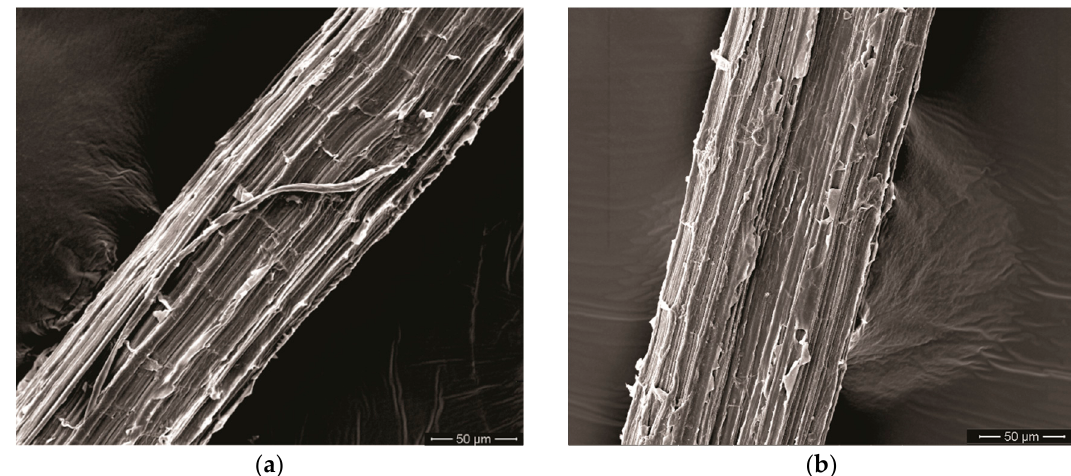
Figure 8. Scanning electron microscopy (SEM) micrographs of both investigated curaua fibers: ( a ) non-coated CF; ( b ) GOCF.